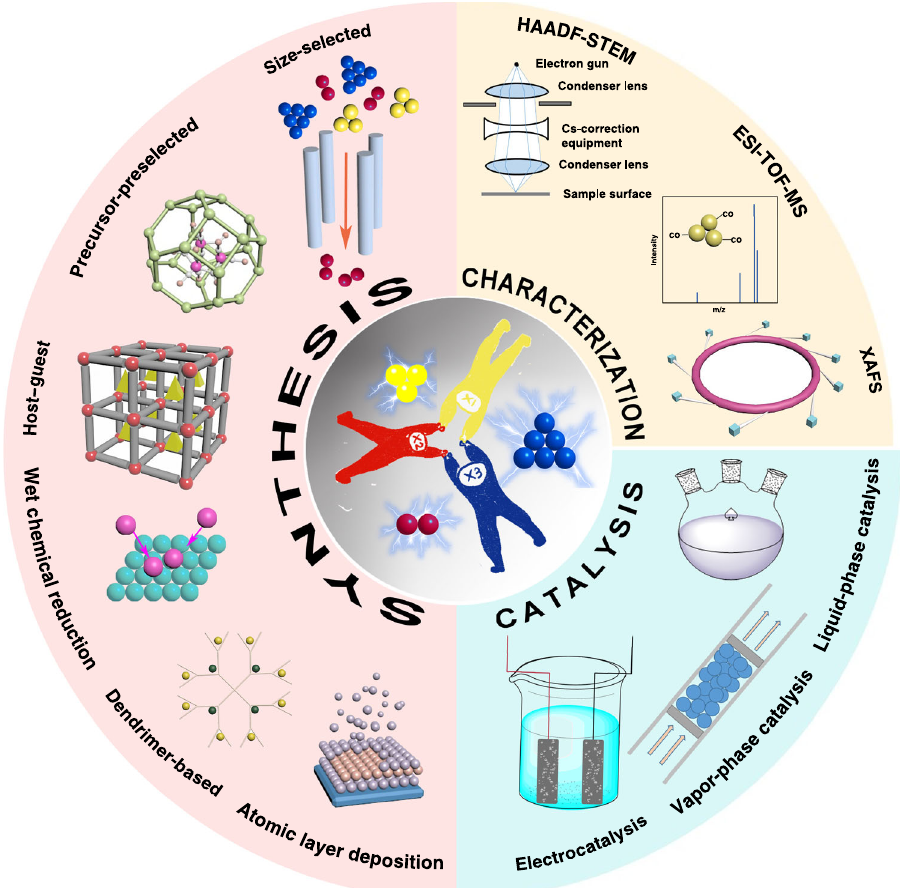
Fig. 2 Synthesis and catalytic performances of supported atomic clusters. Schematics for the size-selected, precursor-preselected, host – guest, wet chemical reduction, dendrimer-based, and atomic layer deposition strategies of supported atomic clusters; HAADF-STEM, ESI-TOF-MS, and XAFS are three important and typical characterization techniques; the electrochemical, vapor-, and liquid-phase catalytic performances of supported atomic